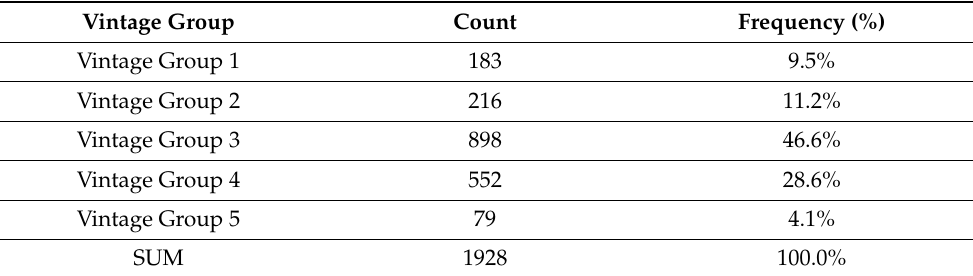
Table 7. Proportions of public buildings by vintage